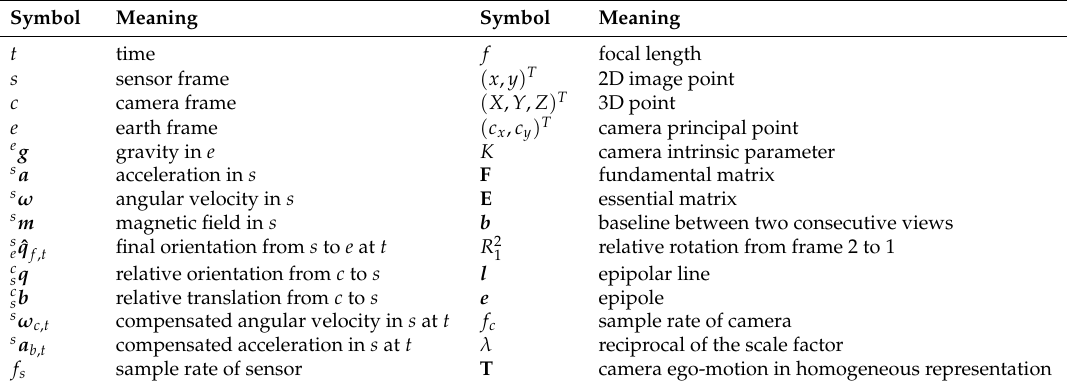
Table 2. Definitions of mathematical symbols and